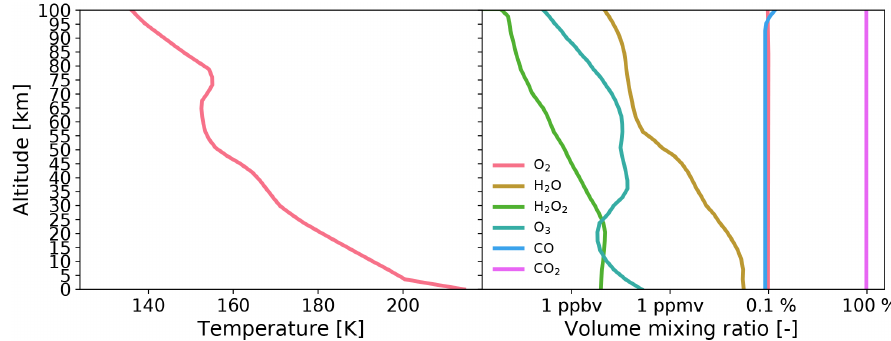
Figure 2. Temperature and volume mixing ratio profiles used in the simulations.